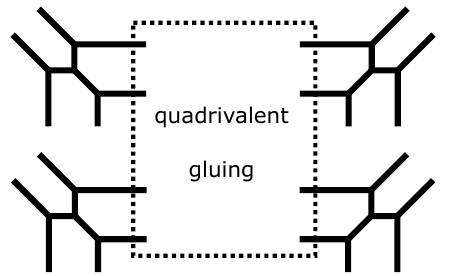
Figure 1. The web diagram for the minimal ( D 4 , D 4 ) conformal matter theory on a circle.